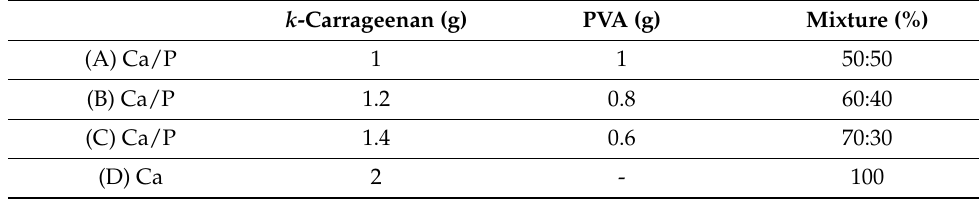
Table 1. The formulation of k -Carrageenan/PVA nanocomposite composites. k -Carrageenan